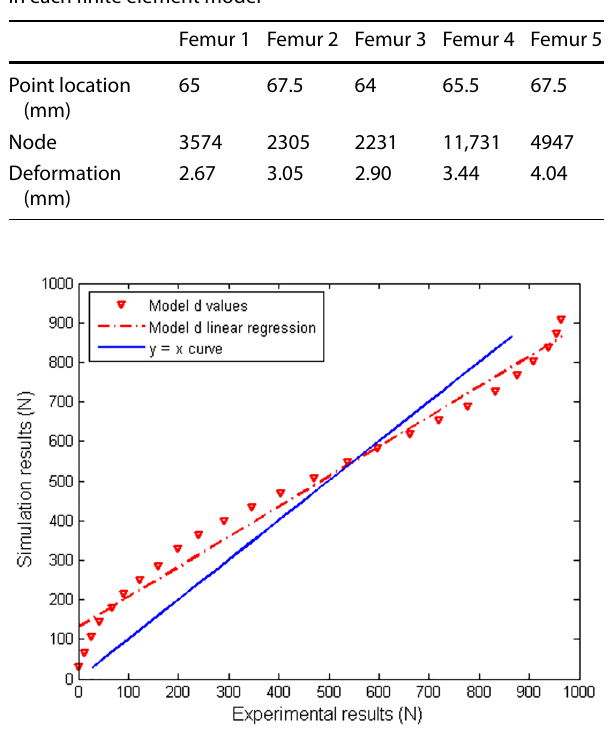
Fig. 6 Linear regression curve for model-d corresponding to one of the five specimens (Femur 1). The regression curves for the other femora show similar characteristics